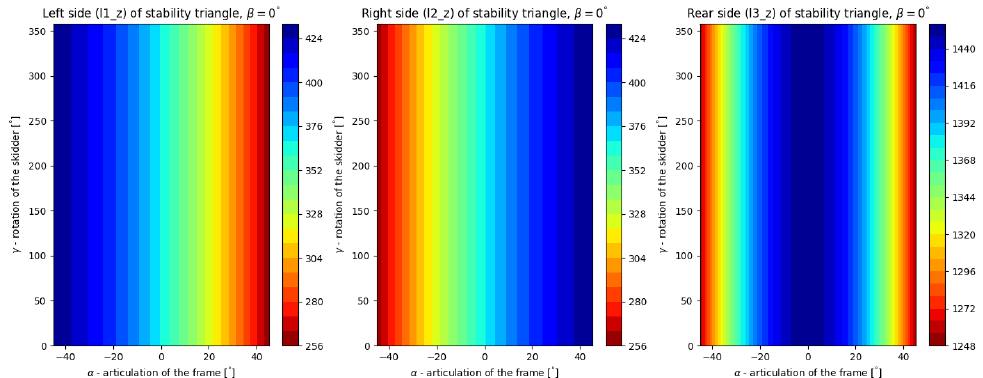
Figure 6. Stability plot for unloaded skidder (C1 configuration) on horizontal plane. Color bars show the distance of the gravity vector (for the whole machine) to tipping lines in [mm].